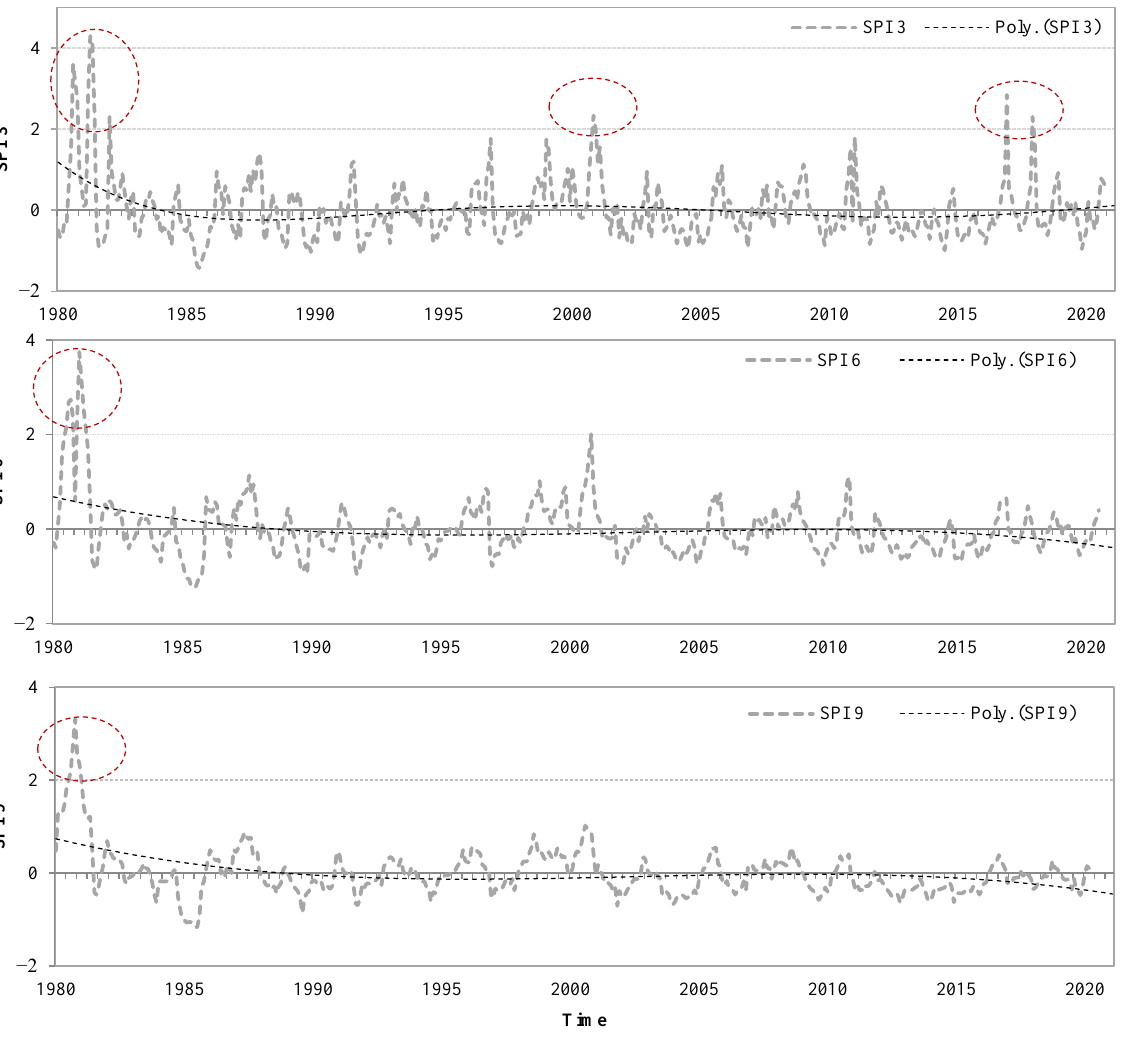
Figure 4. Drought time series at 3, 6, and 9 monthly SPI for the Tri Ton meteorological station. The best-fit lines using polynomial (Poly).